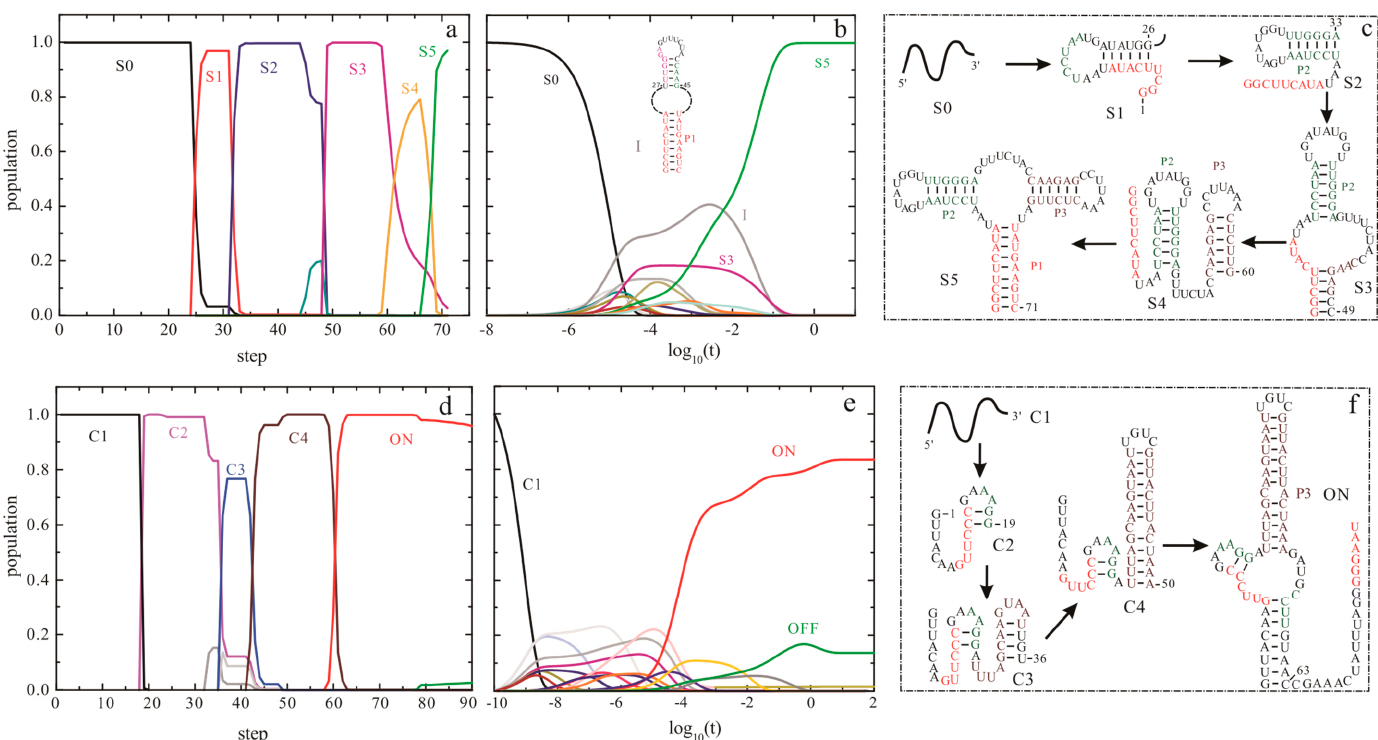
Figure 5. The co-transcriptional folding kinetics ( a , d ) and refolding kinetics ( b , e ) of addA riboswitch aptamer (up panel) and S MK riboswitch (bottom panel). The transcription rates for addA aptamer and S MK riboswitch are 25 nt/s and 50 nt/s, respectively, and the main intermediate states formed during the transcription are shown in ( c , f ). The dash dot lines in ( b ) for addA riboswitch aptamer denote the unpaired nucleotides within the large inter-loop. OFF state of S MK riboswitch is the structure that is responsible for SAM binding shown in Figure 1.